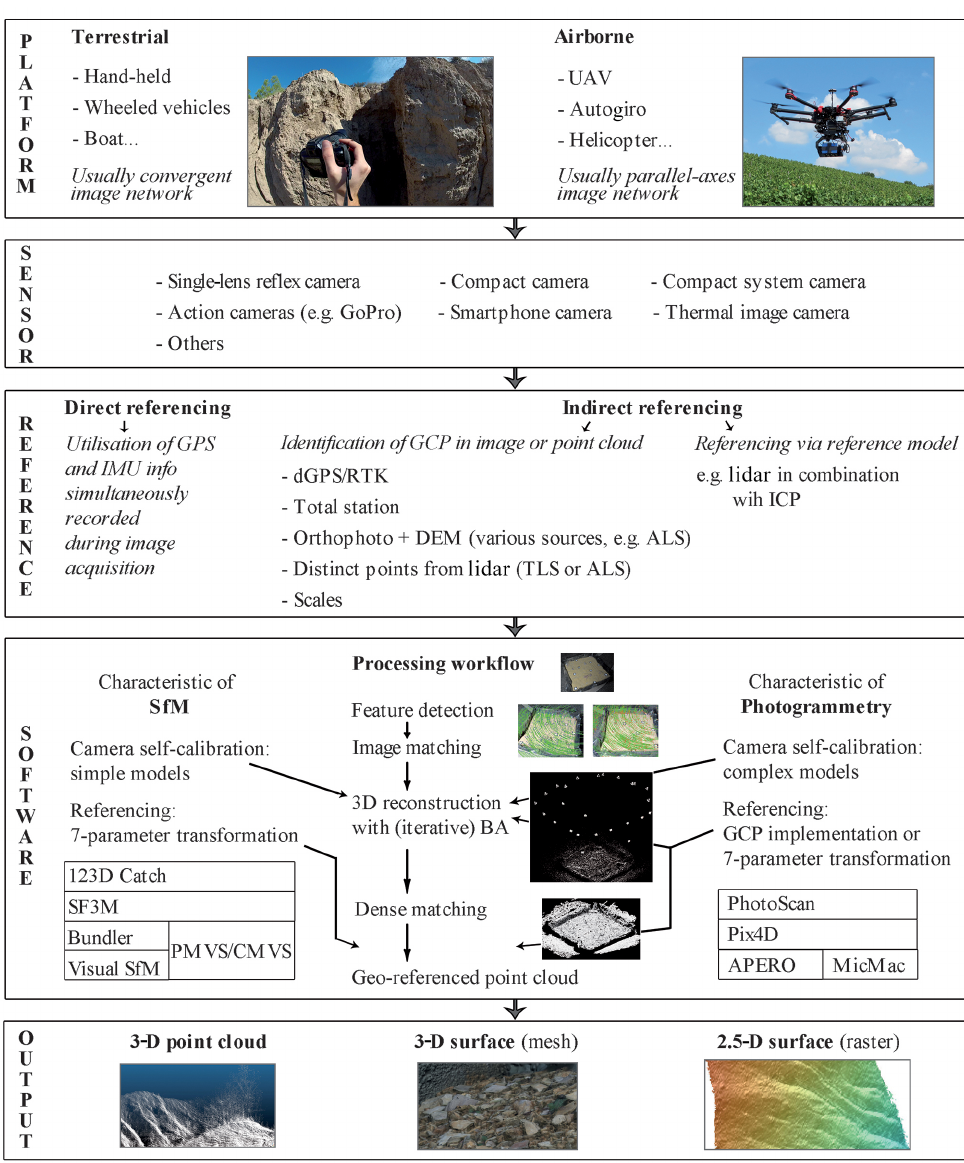
of (digital) photogrammetry. Software and hardware